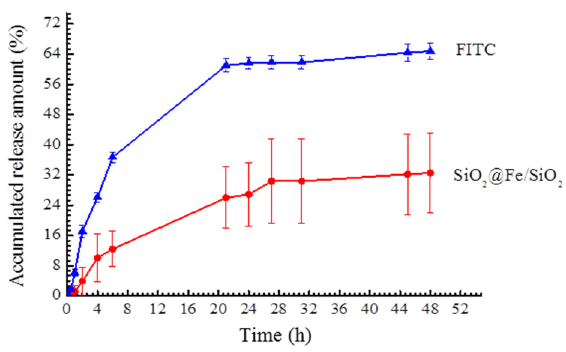
Figure 4. FITC loaded in SiO 2 @Fe/SiO 2 composite spheres to examine the dye (FITC) release behavior for drug release applications (soaking in PBS at pH 7.4, 37 °C).